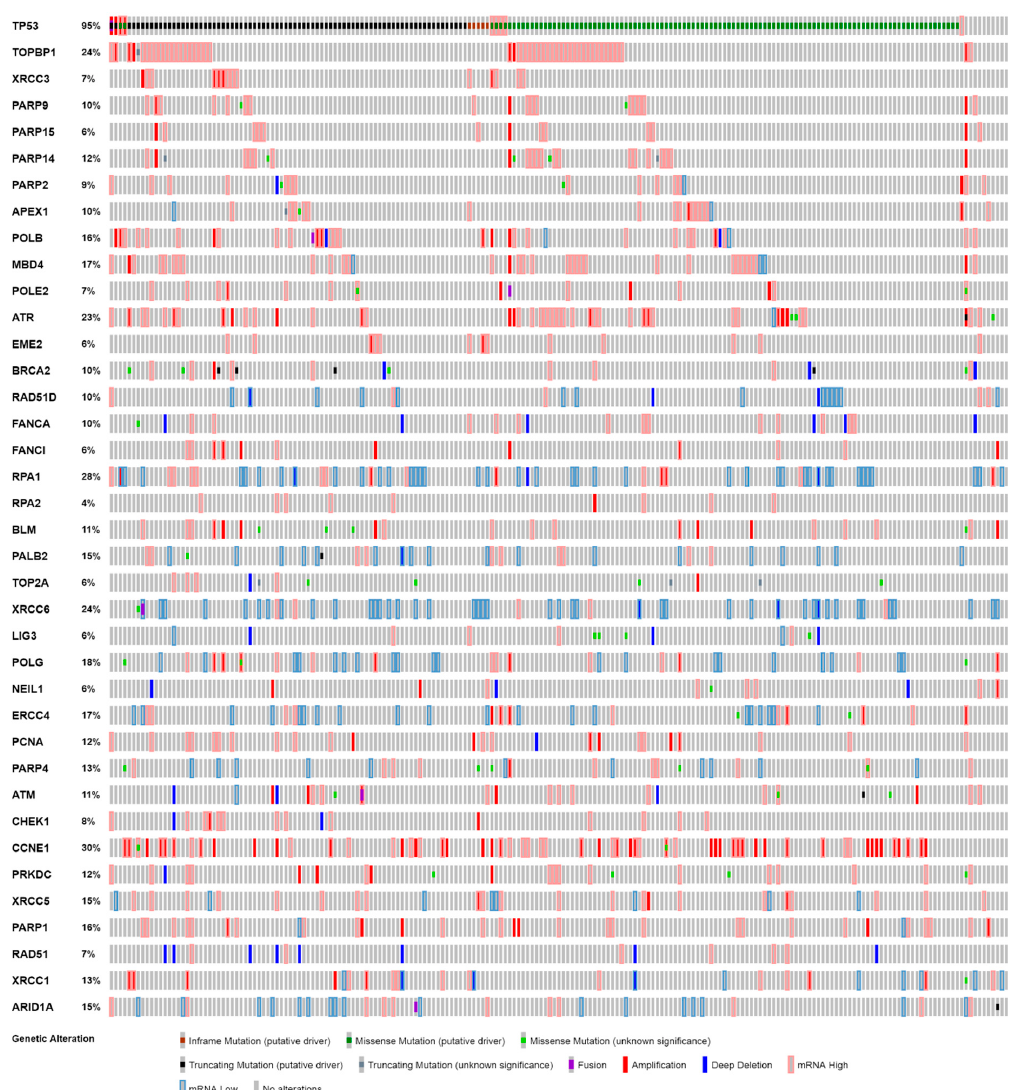
Figure 5. Distribution of genomic and transcriptomic alterations of select DDR genes among 201 HGSOCs. ( A ) Alteration frequencies of TP53 and DDR genes with amplification and deep deletion in NIH-OVCAR3 cell lines and additional DDR genes analysed as likely determinants of ATRi resistance in NIH-OVCAR3 cell line. Figure generated using cBioPortal (https://www.cbioportal.org/).